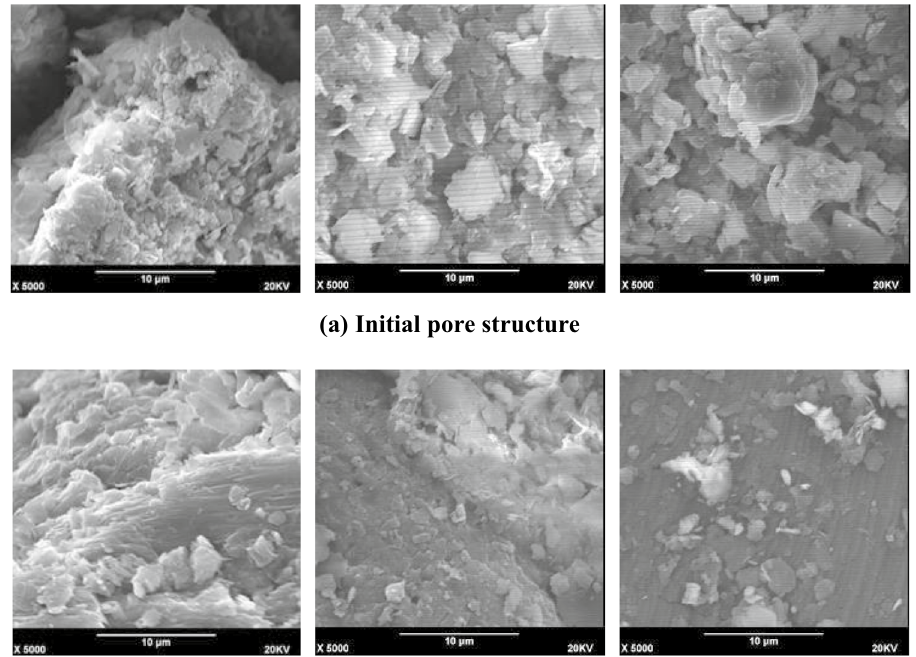
Fig. 2 Comparison of pore structure before and after super- heated steam injection using scanning electron microscope (Zhou 2010)